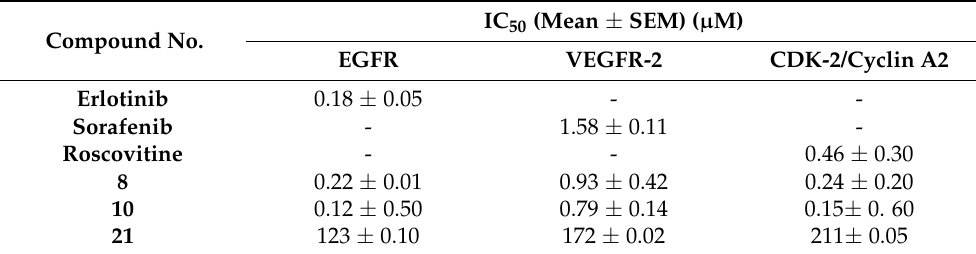
Table 3. Kinase inhibitory assessment of the promising derivatives 8 , 10 and 21 against EGFR, VEGFR-2 and CDK-2/cyclinA2 comparing with erlotinib, sorafenib and roscovitine, respectively. Compound No.